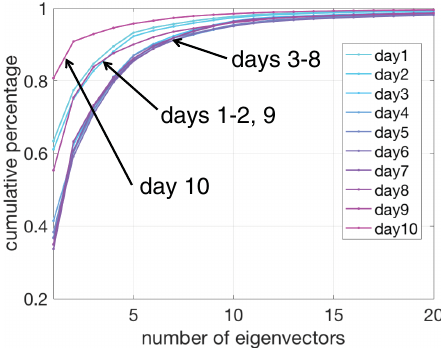
FIG. 6. Cumulative variation explained by number of eigen- vectors from PCA of the LCLS laser profiles. To capture 80% of the total variation, it takes 1 to 5 eigenvectors depending on the day. The total number of eigenvectors is